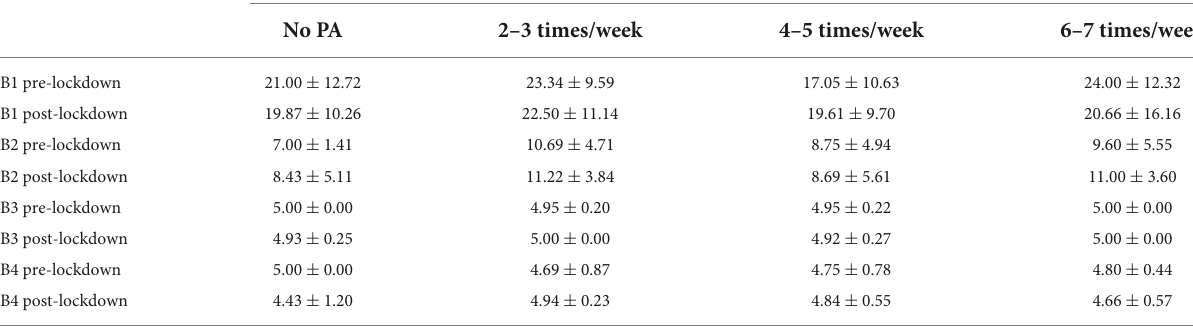
TABLE 2 Pre- and post-lockdown balance test scores in relation to the frequency of children who were not physically active using descriptive